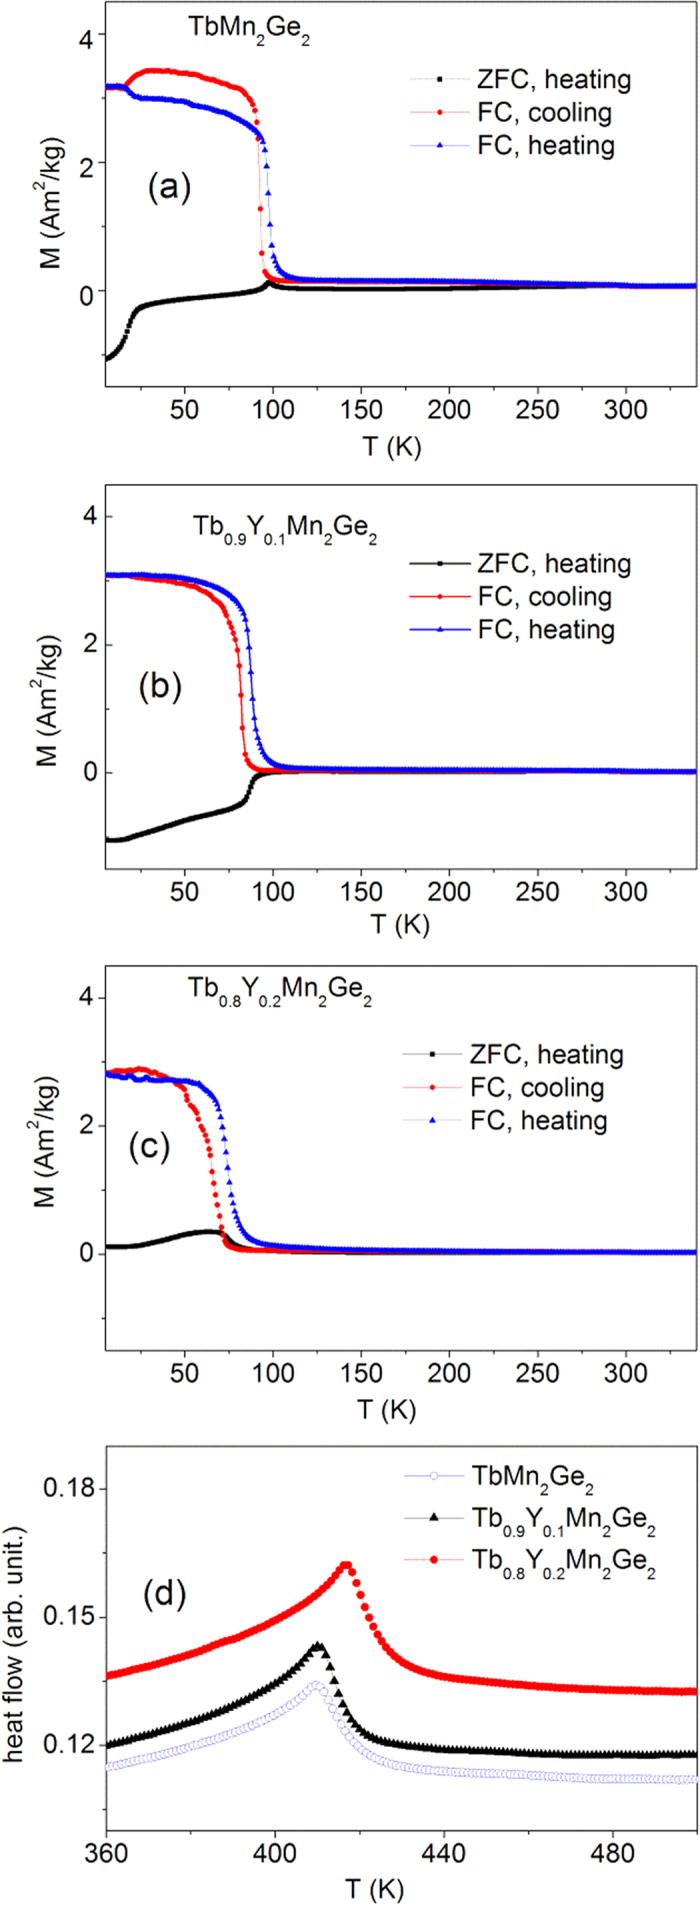
Temperature dependence of magnetization on ZFC heating, FC cooling and FC heating processes under a field of B = 0.01 T: (a) TbMn2Ge2, (b) Tb0.9Y0.1Mn2Ge2 and (c) Tb0.8Y0.2Mn2Ge2. (d) the differential scanning calorimetry curves for the three samples over the range ~300–500 K.